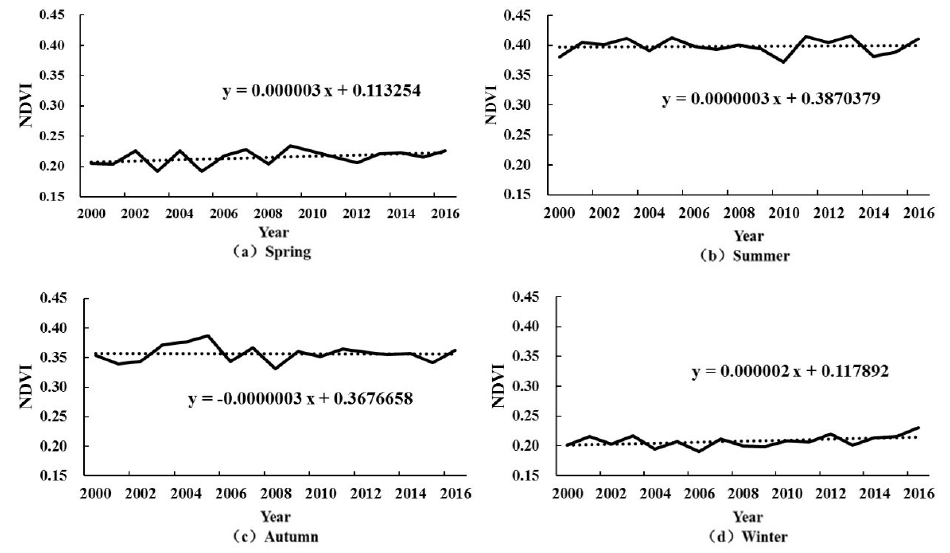
Figure 2. Seasonal variation of NDVI in the Yarlung Zangbo River